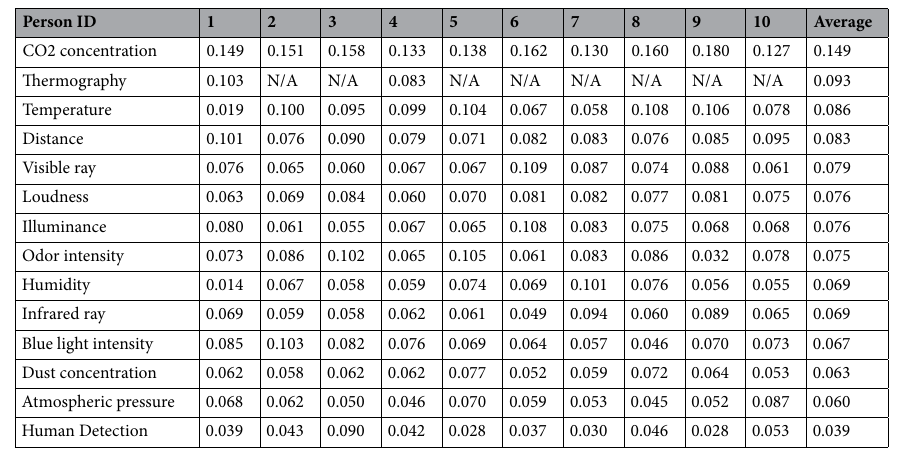
Table 9. Importance of each